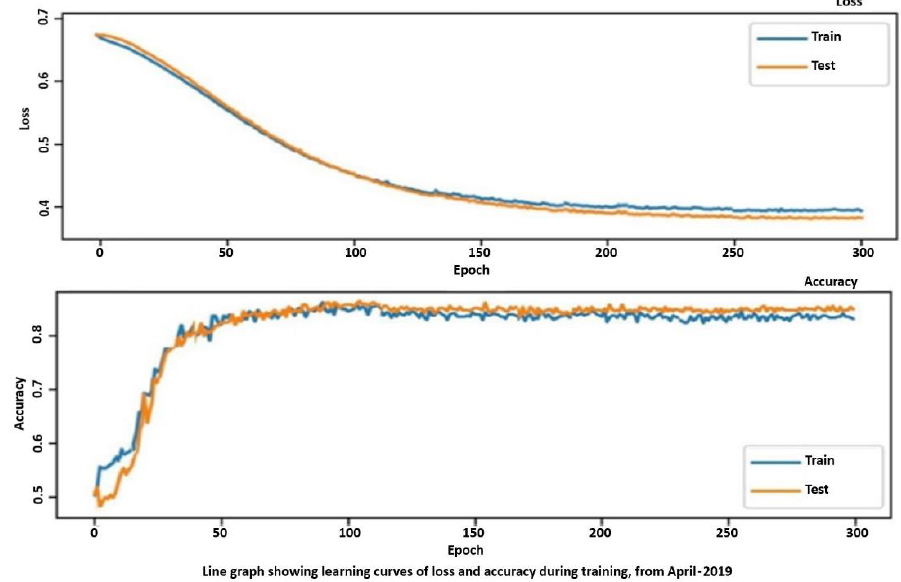
Figure 12. Accuracy vs. long epoch and loss illustration in April 2019.